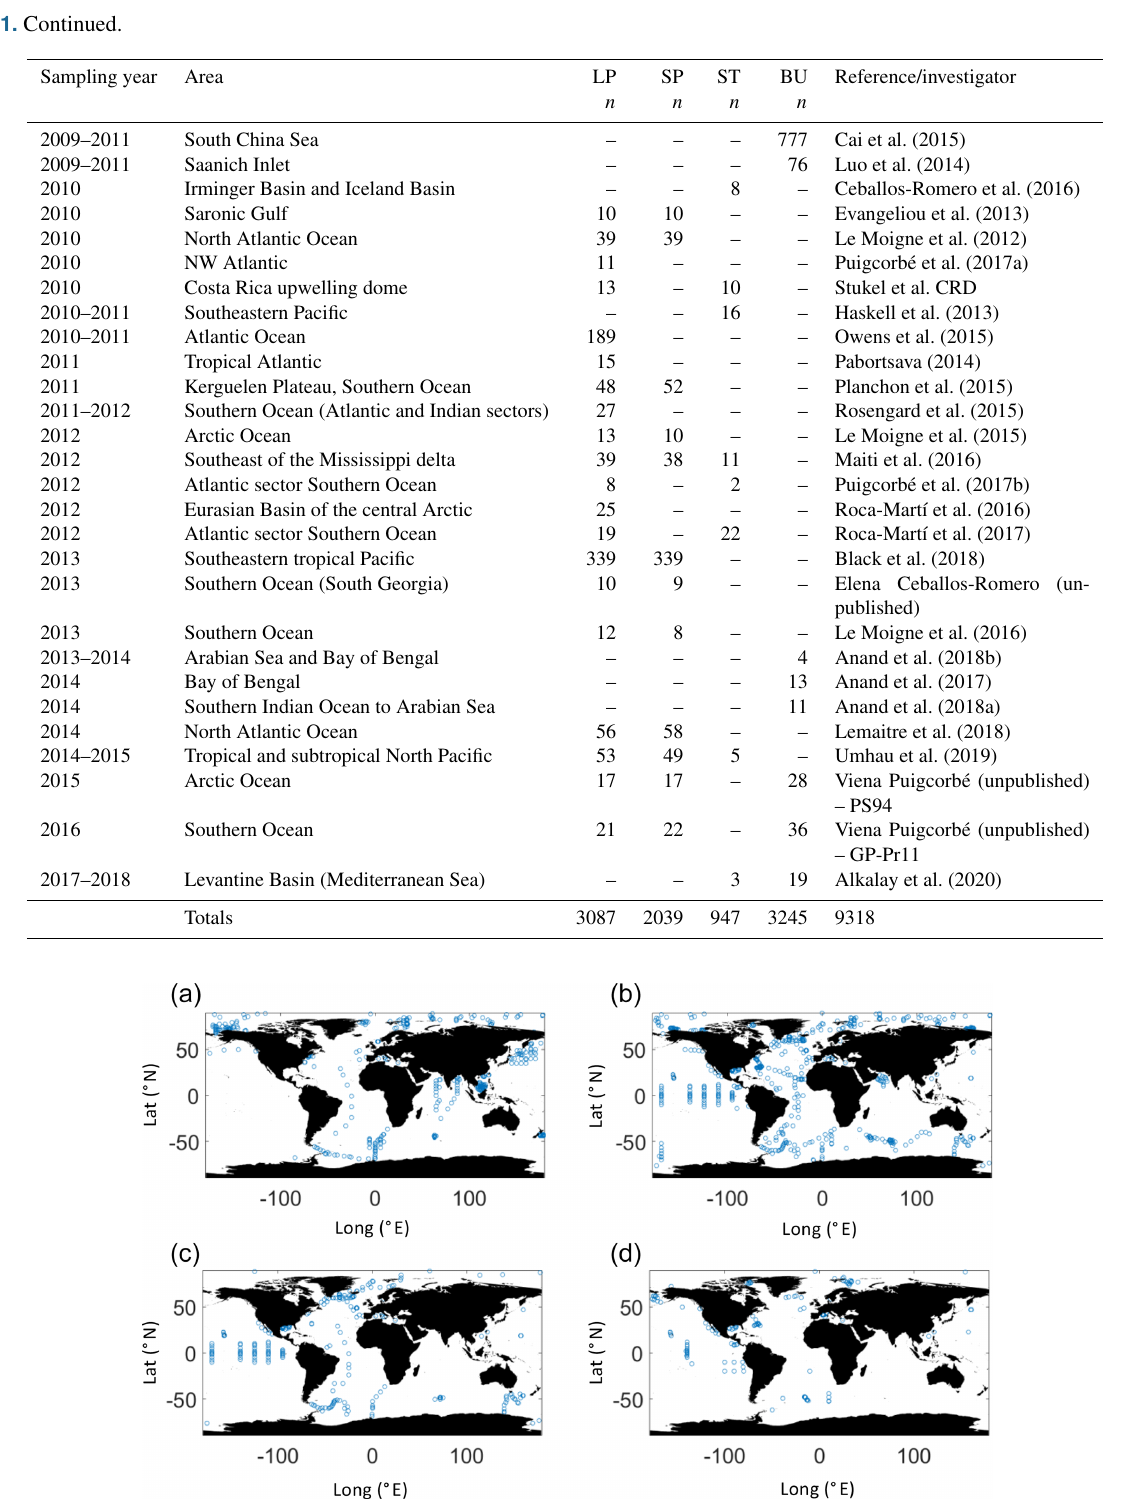
Figure 1. Maps showing the distribution of POC / Th ratios measured on (a) bulk particles, (b) large particles, (c) small particles, and (d) particles from sediment traps. See main text for details, Sect. 3.1 Data